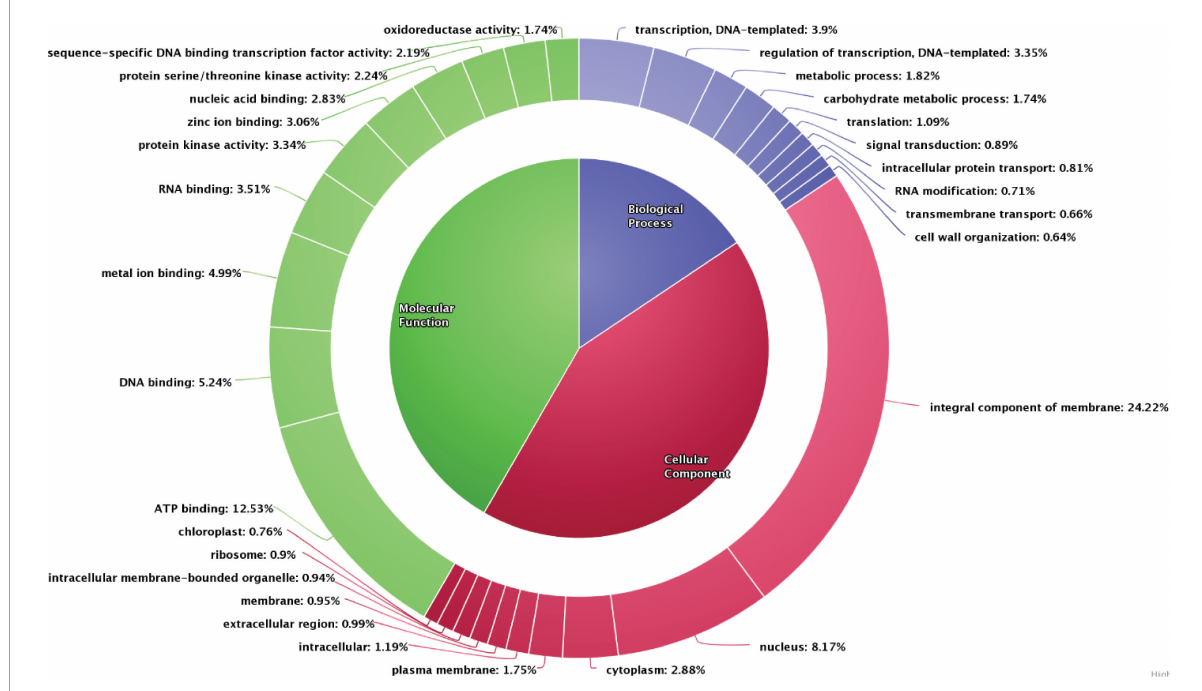
FIGURE3 Gene ontology distribution of the scaffolds into the biological process, molecular function, and the cellular component. The number of scaffolds encoded for each category is